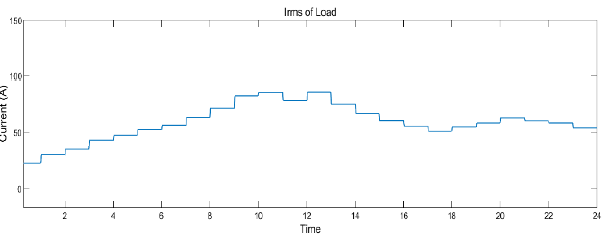
Fig.17. Reactive power of load in switching condition